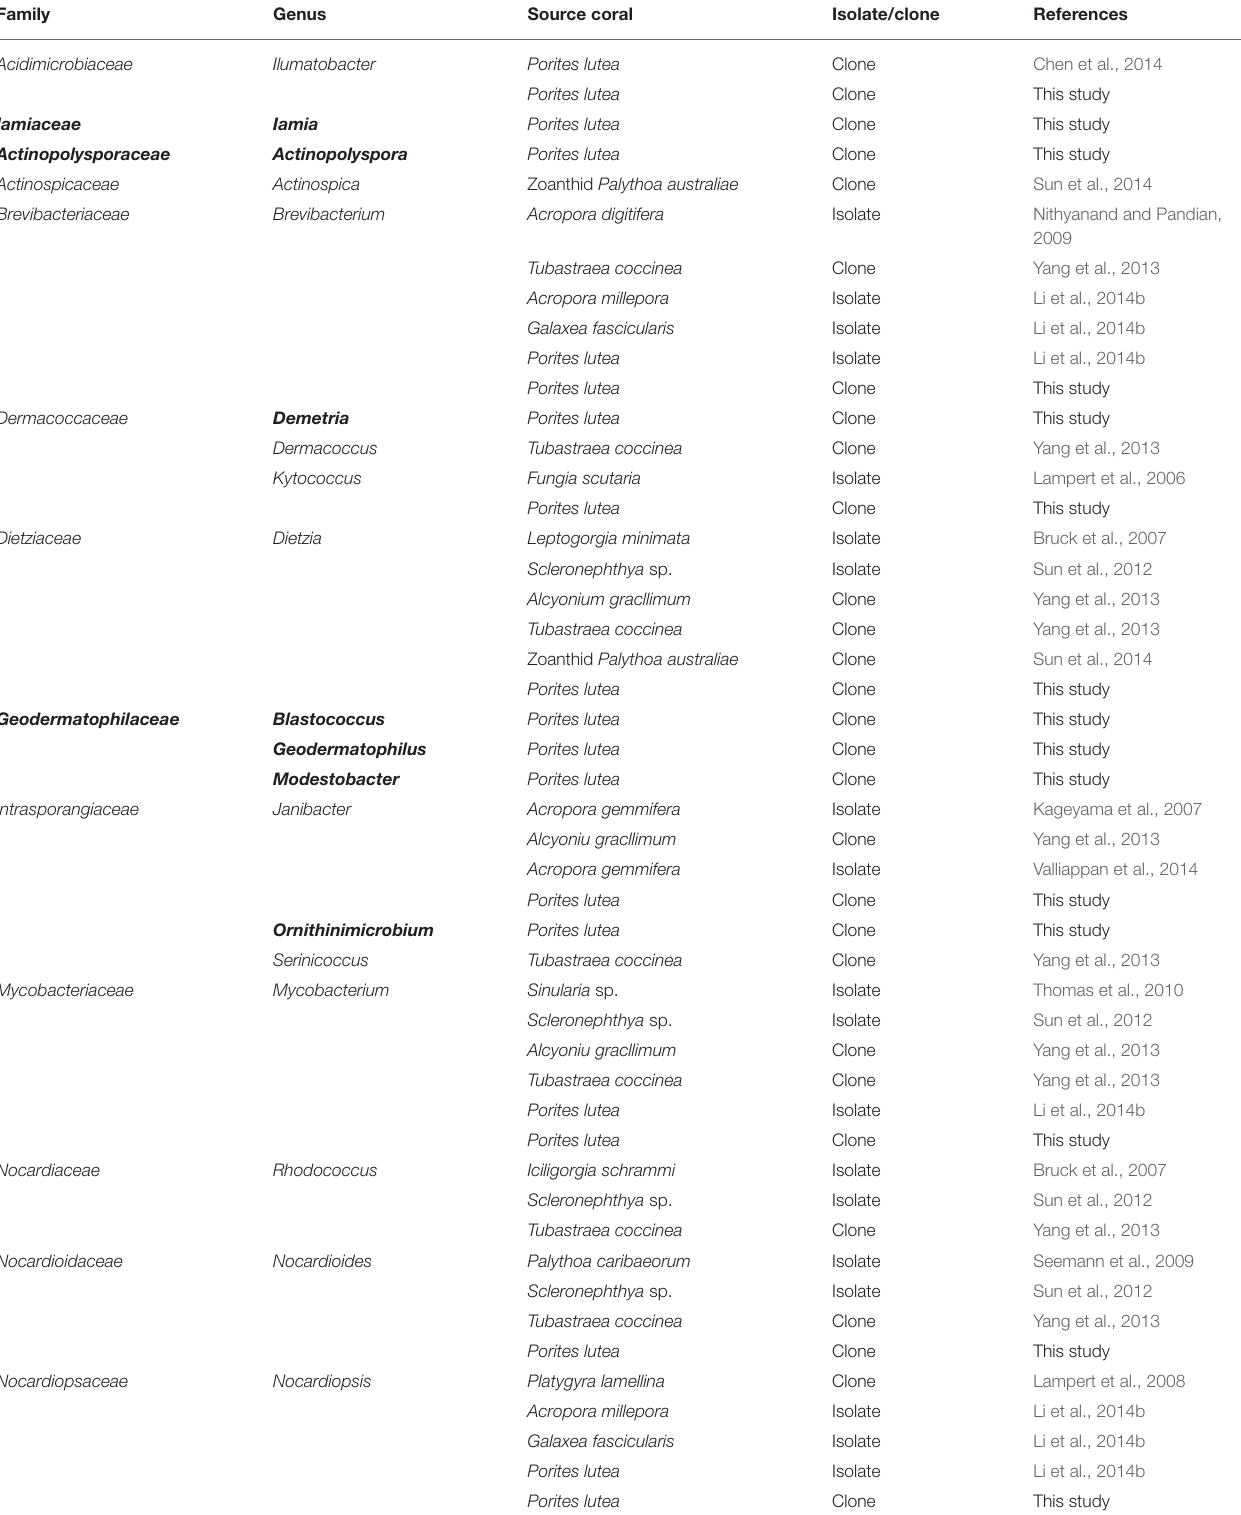
TABLE 4 | Summary of the Actinobacteria associated with